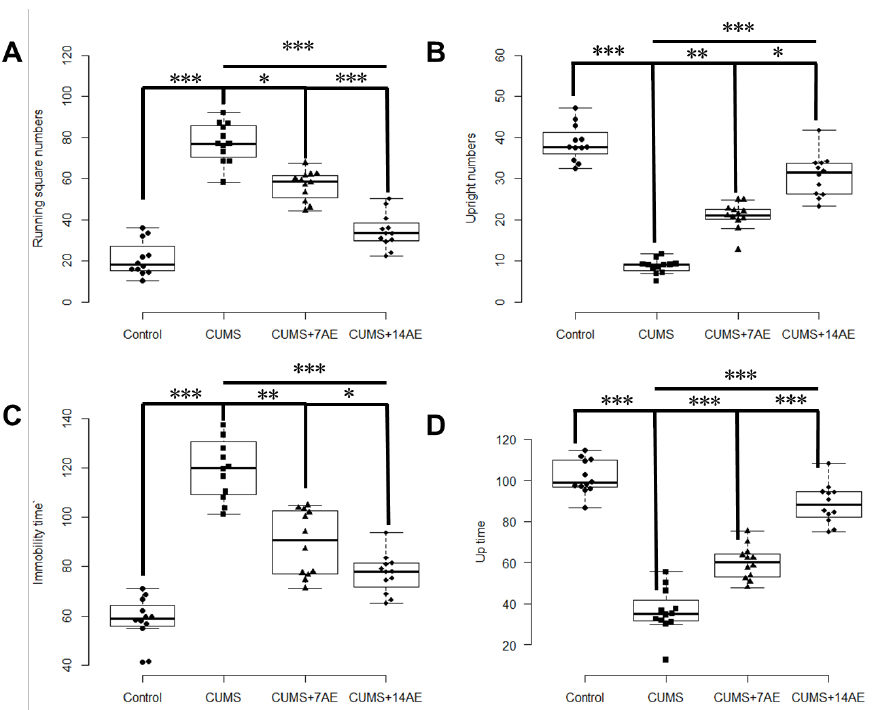
Figure 2. Effects of aerobic exercise on CUMS-induced behaviors, i.e., running square numbers (times · (5 min) − 1 ) ( A ), upright numbers (times · (5 min) − 1 ) ( B ), immobility time (times · (5 min) − 1 ) ( C ),